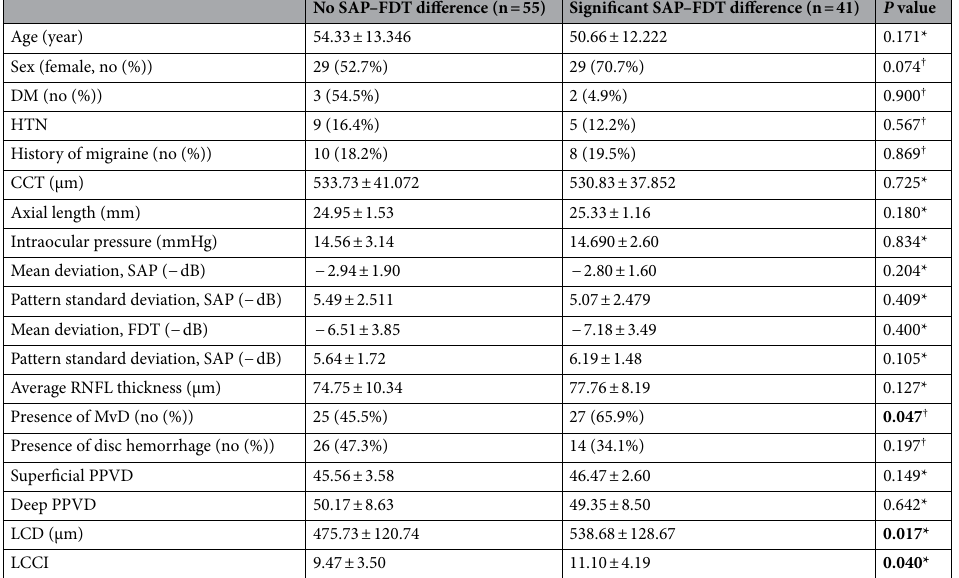
Table 1. Comparison of the demographics and test results between significant SAP–FDT difference. The significant SAP–FDT difference is defined as depressed points of P < 5% and P < 1% on the PSD plot greater than 4 points. Mean values are presented with standard deviations. No number, DM diabetes, HTN hypertension, CCT central corneal thickness, RNFL retinal nerve fiber layer, MvD microvascular